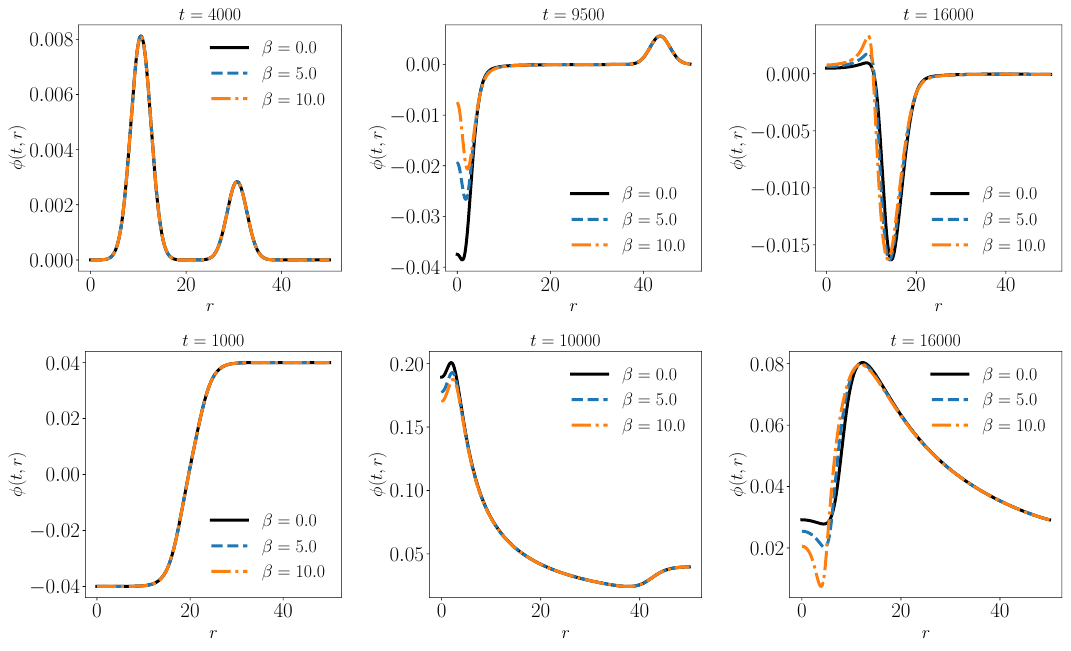
Figure 1 . Scalar (cid:12)eld pro(cid:12)le (cid:30) in the weak (cid:12)eld regime, for (cid:12) = 0 : 0 (solid line), (cid:12) = 5 : 0 (dashed line) and (cid:12) = 10 : 0 (dash-dotted line). Upper panel is for Gaussian family type of initial conditions (Family A) while the bottom panel represents family